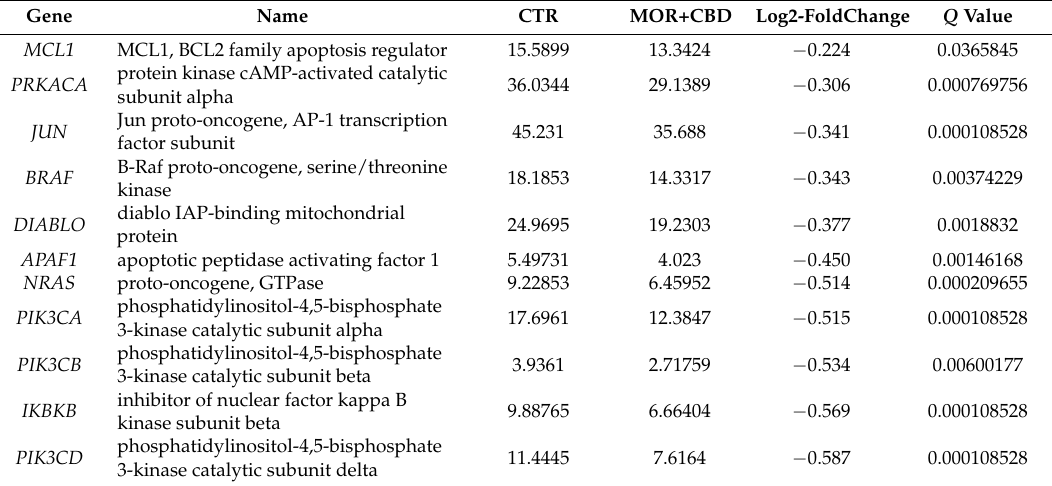
Table 3. Downregulated genes involved in “Inhibition of